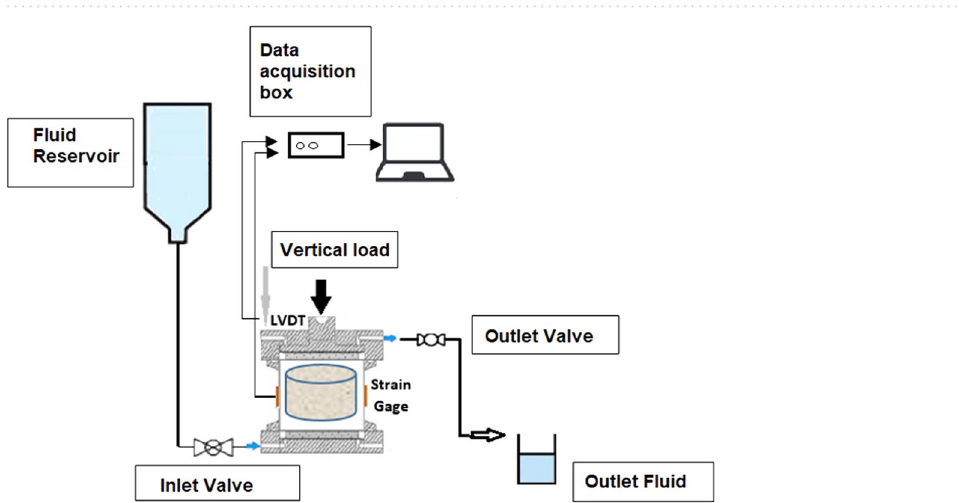
Figure 8. ( A ) Edometric cell diagram comprised of (a) upper, (b) lower, and (c) sample confinement rings and (d) piston for vertical load application. ( B ) Modified edometric cell, highlighting the strain gauge in the confinement ring and the LVDT in the upper part of the cell. Reference: Modified 21,38,39 .